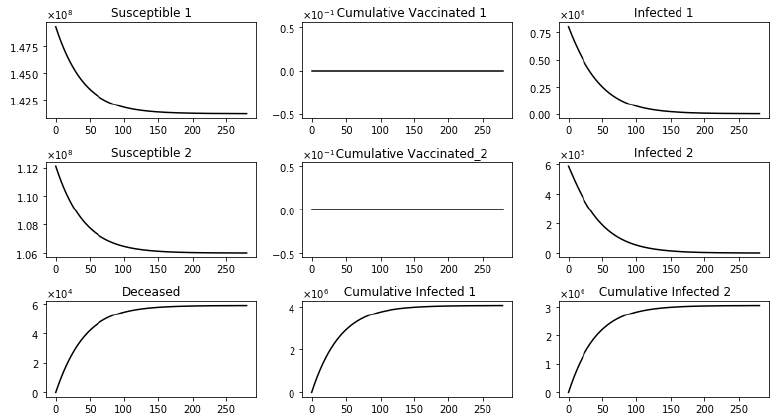
Figure 3. Dynamics of several subpopulations without a vaccination program.